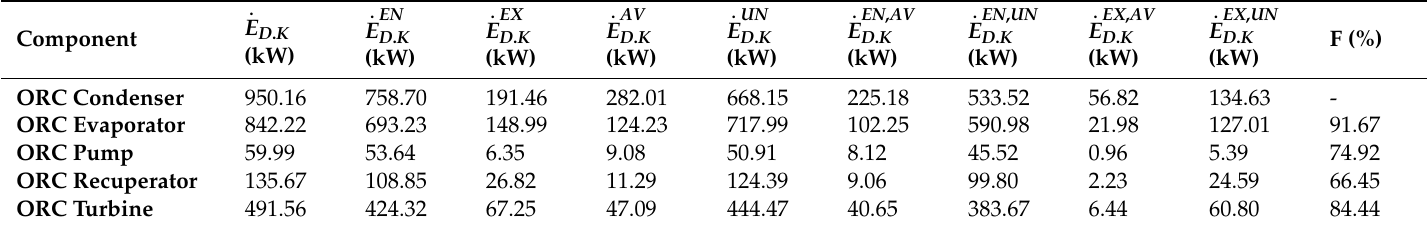
Table 13. The results of advanced exergy analysis of the standalone geothermal cycle (GPP). Component